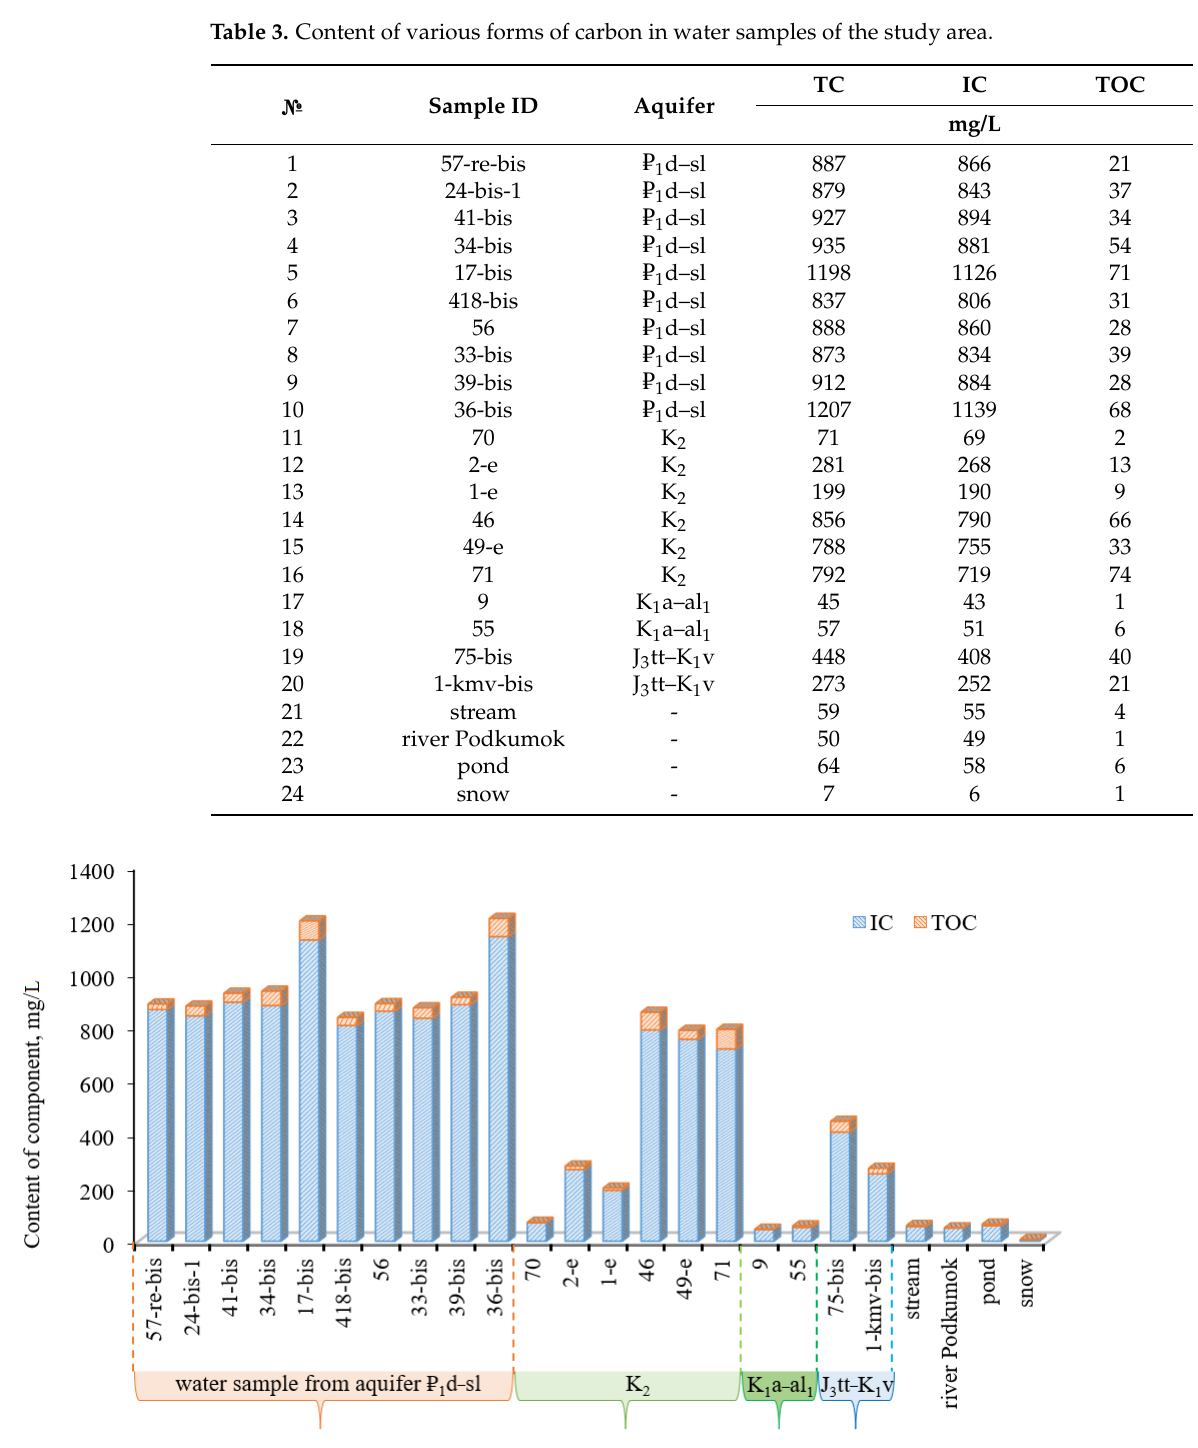
Table 3. Content of various forms of carbon in water samples of the study area.